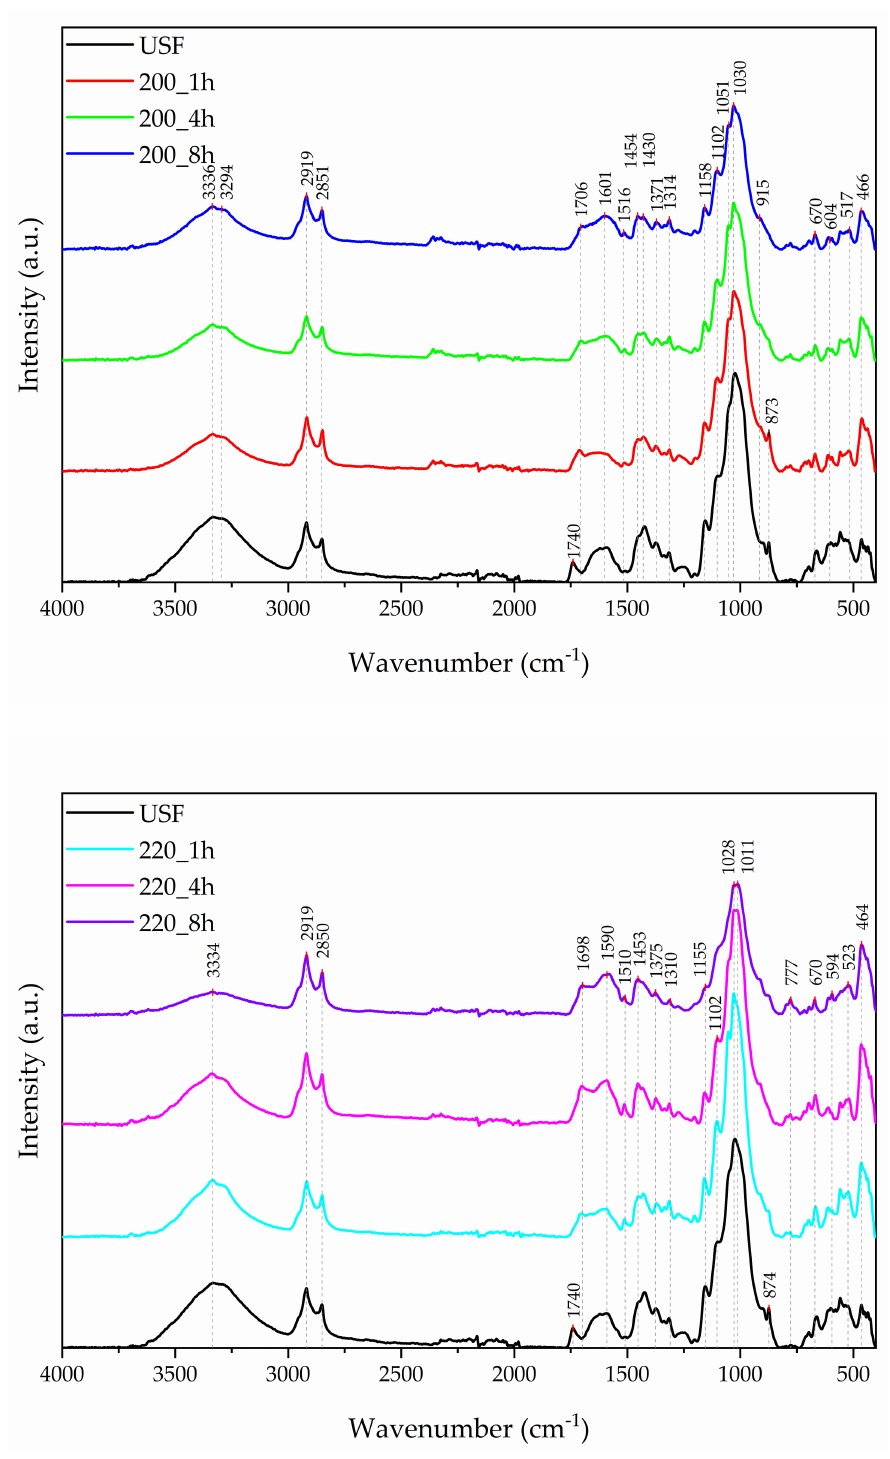
Figure 7. FTIR spectra of the USF and